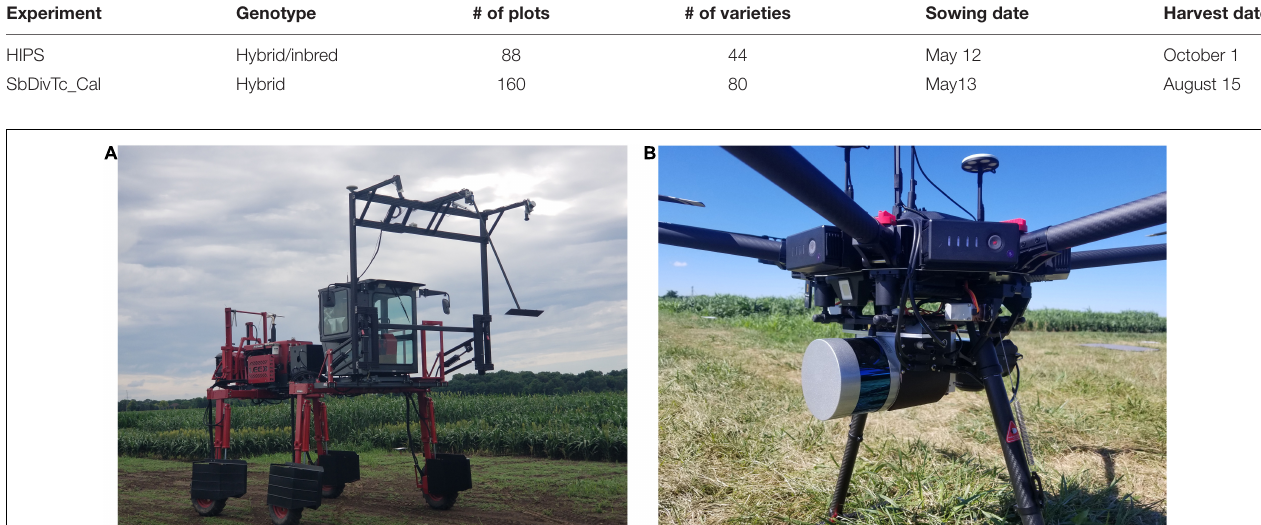
TABLE 1 | Experimental design for the 2020 growing season. Experiment